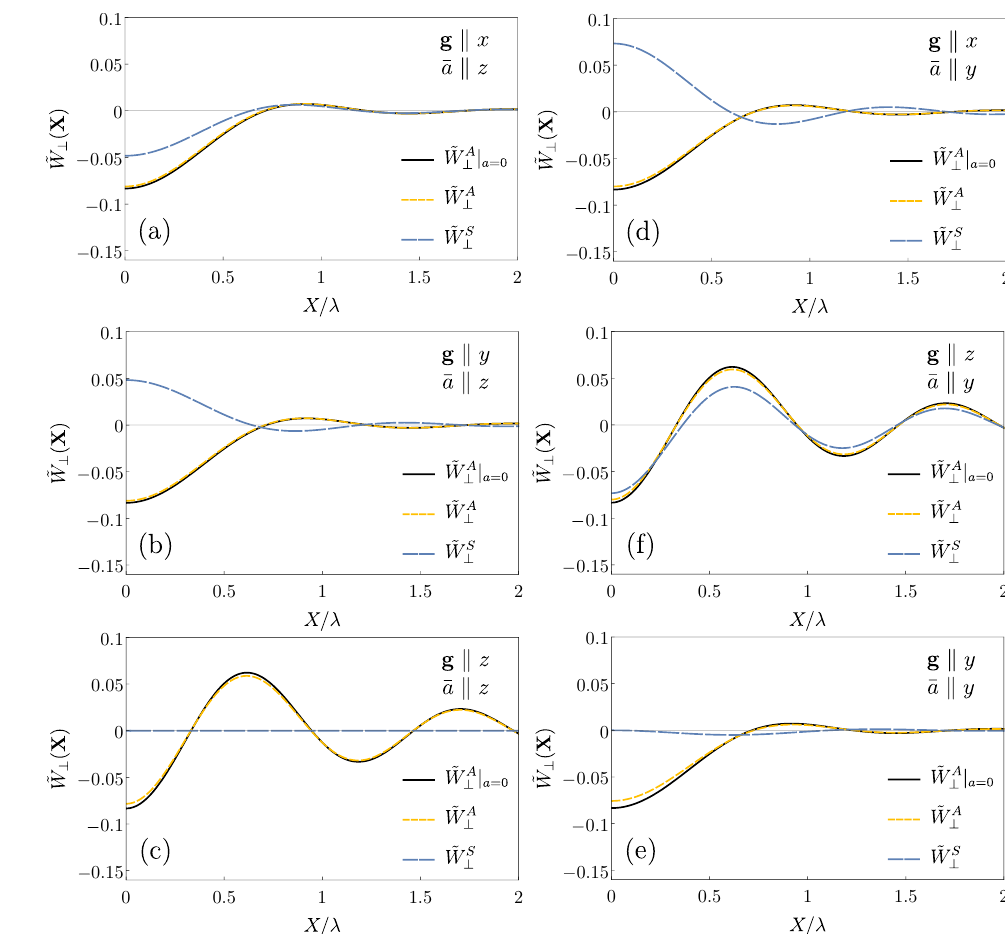
˜ W A Figure 3. Symmetric ˜ W S ⊥ normalized contributions of the electric field corre- ⊥ and antisymmetric lations of the orthogonal polarizations for different directions of the gyration, g , and the anisotropy, ¯ a . Dependence on the gyration value | g | was included in the normalization factor. The anisotropy value is a = 0.07. Five different cases are possible (for X (cid:107) z ): ( a ) and ( b ) The anisotropy is along the observation axis, while the gyration is perpendicular to both of them; ( c ) All three vectors are along the same axis; ( d ) All three vectors are perpendicular to each other; ( e ) The gyration is directed along the anisotropy but perpendicular to the observation axis; ( f ) The gyration is along the observation axis, while the anisotropy is perpendicular to